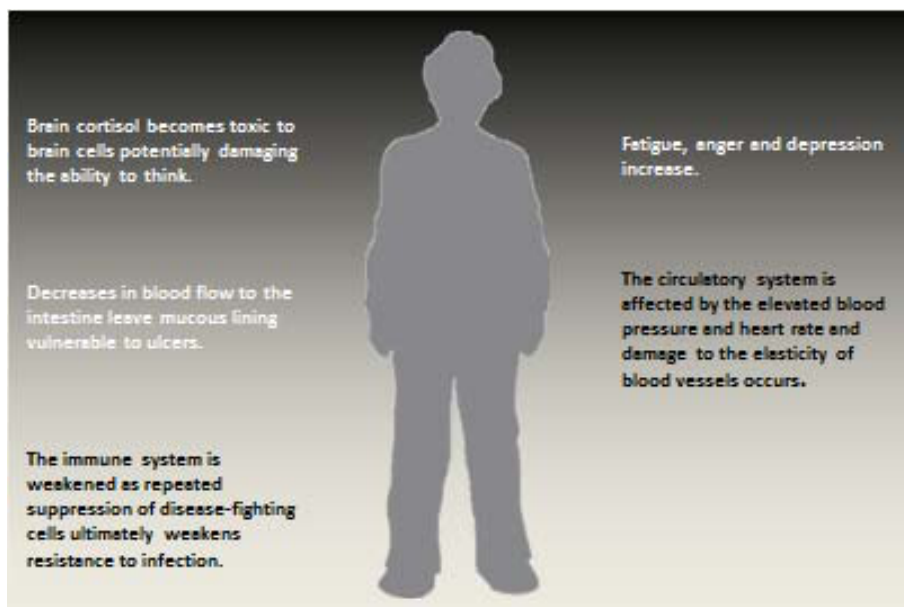
Figure 2. Disease responses to